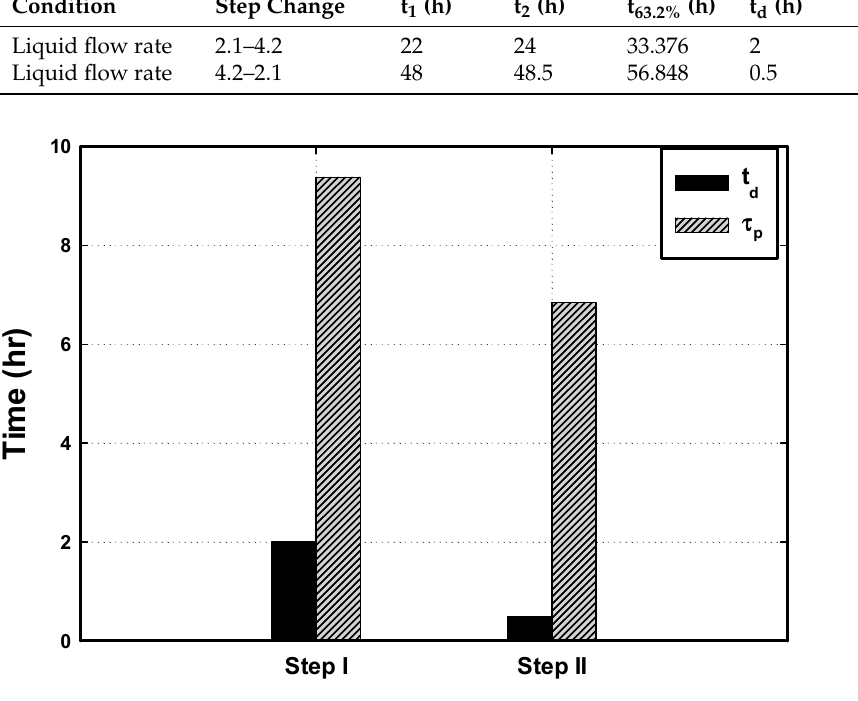
Figure 7. The dead time and reactor time constants for a step change experiment.